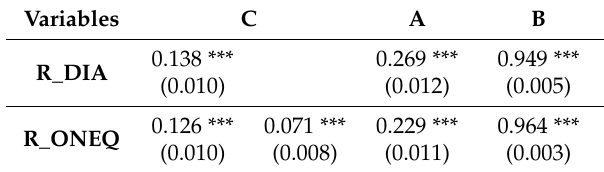
Table 17. Diagonal BEKK for US Market ETF returns (whole period) (3 October 2003 to 30 March 2015). Variables C